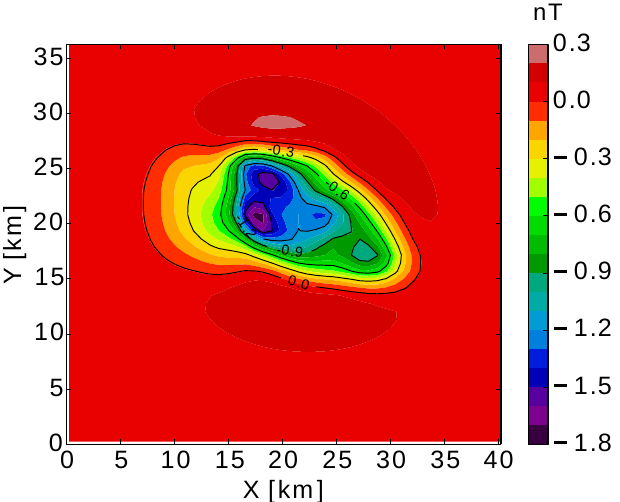
Figure 30. Initial (colour map) and inverted (contour lines) magnetic response for the salt body.